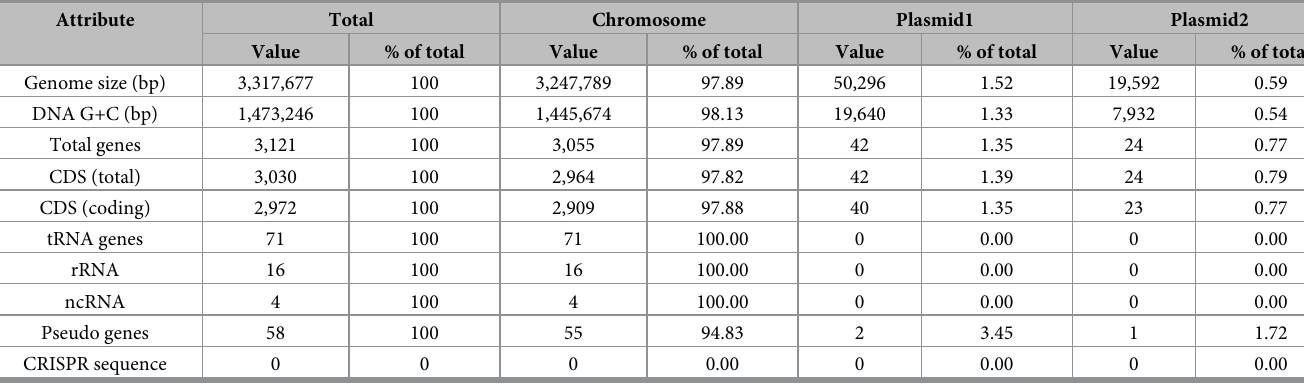
Table 1. Genomic features of Lactiplantibacillus plantarum PMO 08.